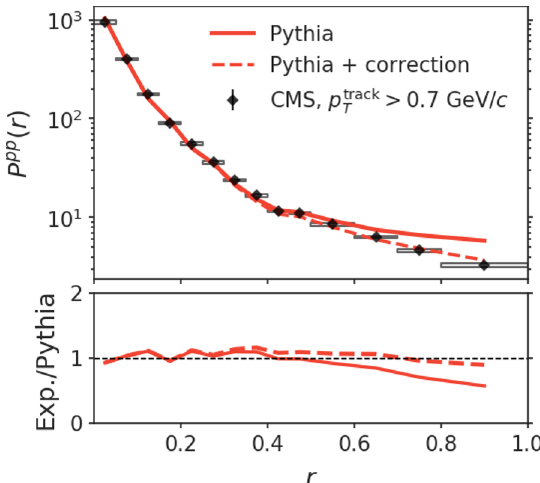
Figure 14 . Pythia8 simulations of inclusive jet shape in proton-proton collision (red-solid line), compared to data from the CMS experiment [109]. The red dashed line corresponds to a “corrected” simulation to better agree with the CMS data at large r . The “corrected” results have been subtracted by a 0.37 GeV per squared radian